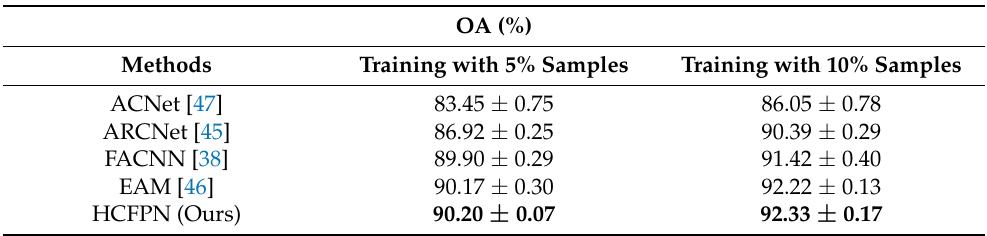
Table 2. Overall accuracy (%) of HCFPN and the comparison methods when trained on the WH- MAVS dataset using a proportion of 5% and 10% of the samples.